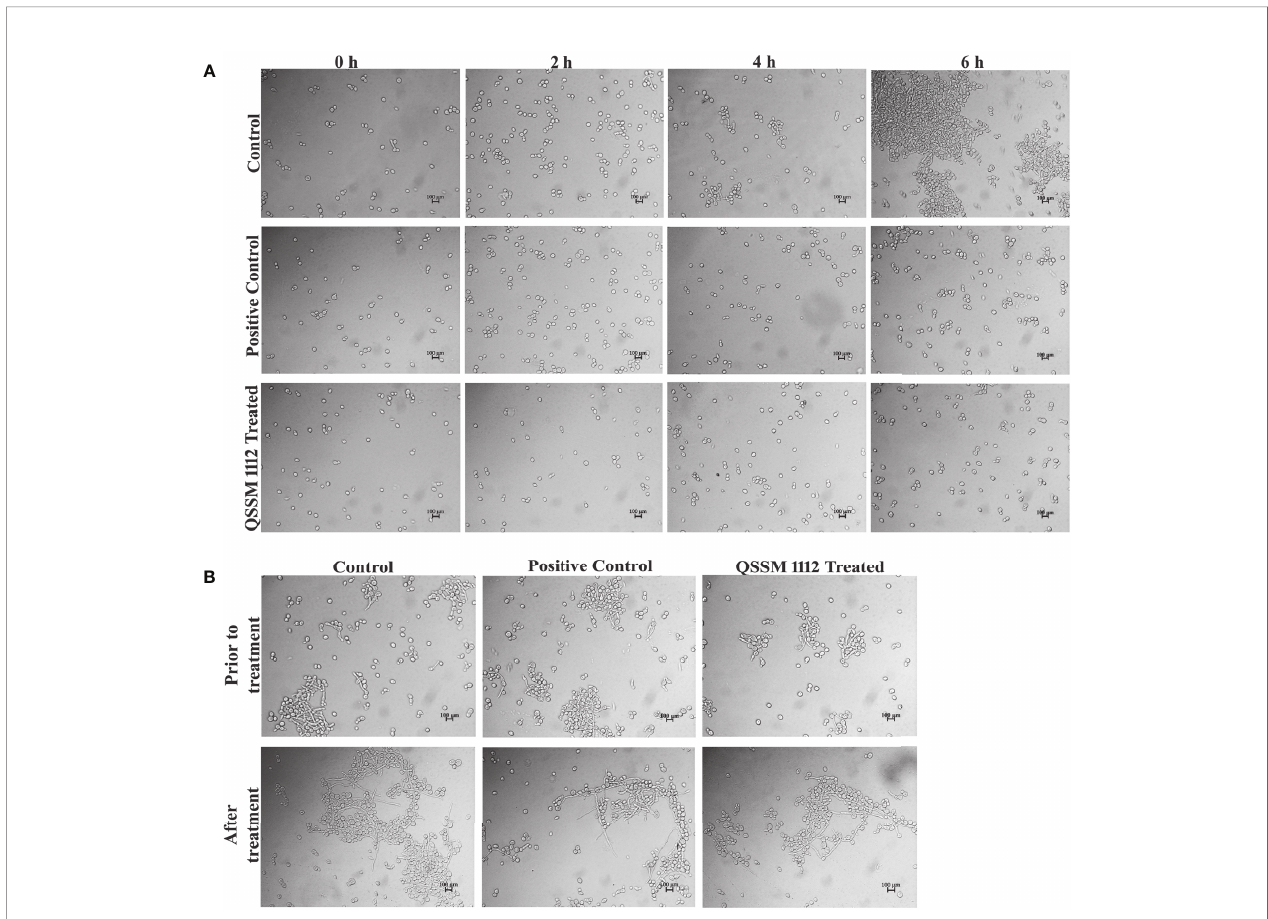
FIGURE 8 | (A) The in fl uence of QSSM 1112 (at HIC) and farnesol on Candida albicans germ-tube formation at various time intervals (0 – 6 h). The QSSM 1112 manifested into the FBS along with the C. albicans cells. The micrograph evidently demonstrates the blockage of germ-tube formation in C. albicans cells treated with QSSM 1112 compared with that of untreated control cells (which encompasses classic badminton structures, i.e., true germ-tubes of C. albicans ). (B) The impact of QSSM 1112 (at HIC) and farnesol on preformed germ-tube formation. There is no signi fi cant difference between untreated control and QSSM 1112- and farnesol-treated cells. FBS, fetal bovine serum; HIC, hyphal inhibitory